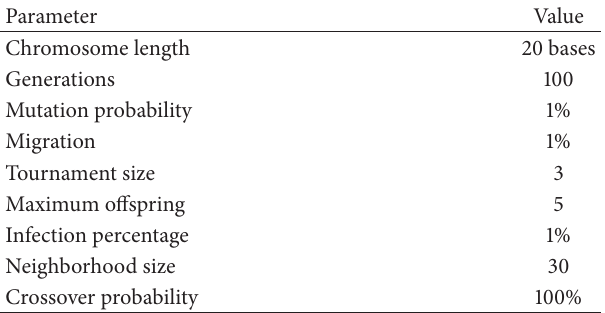
Table 3: Simulation